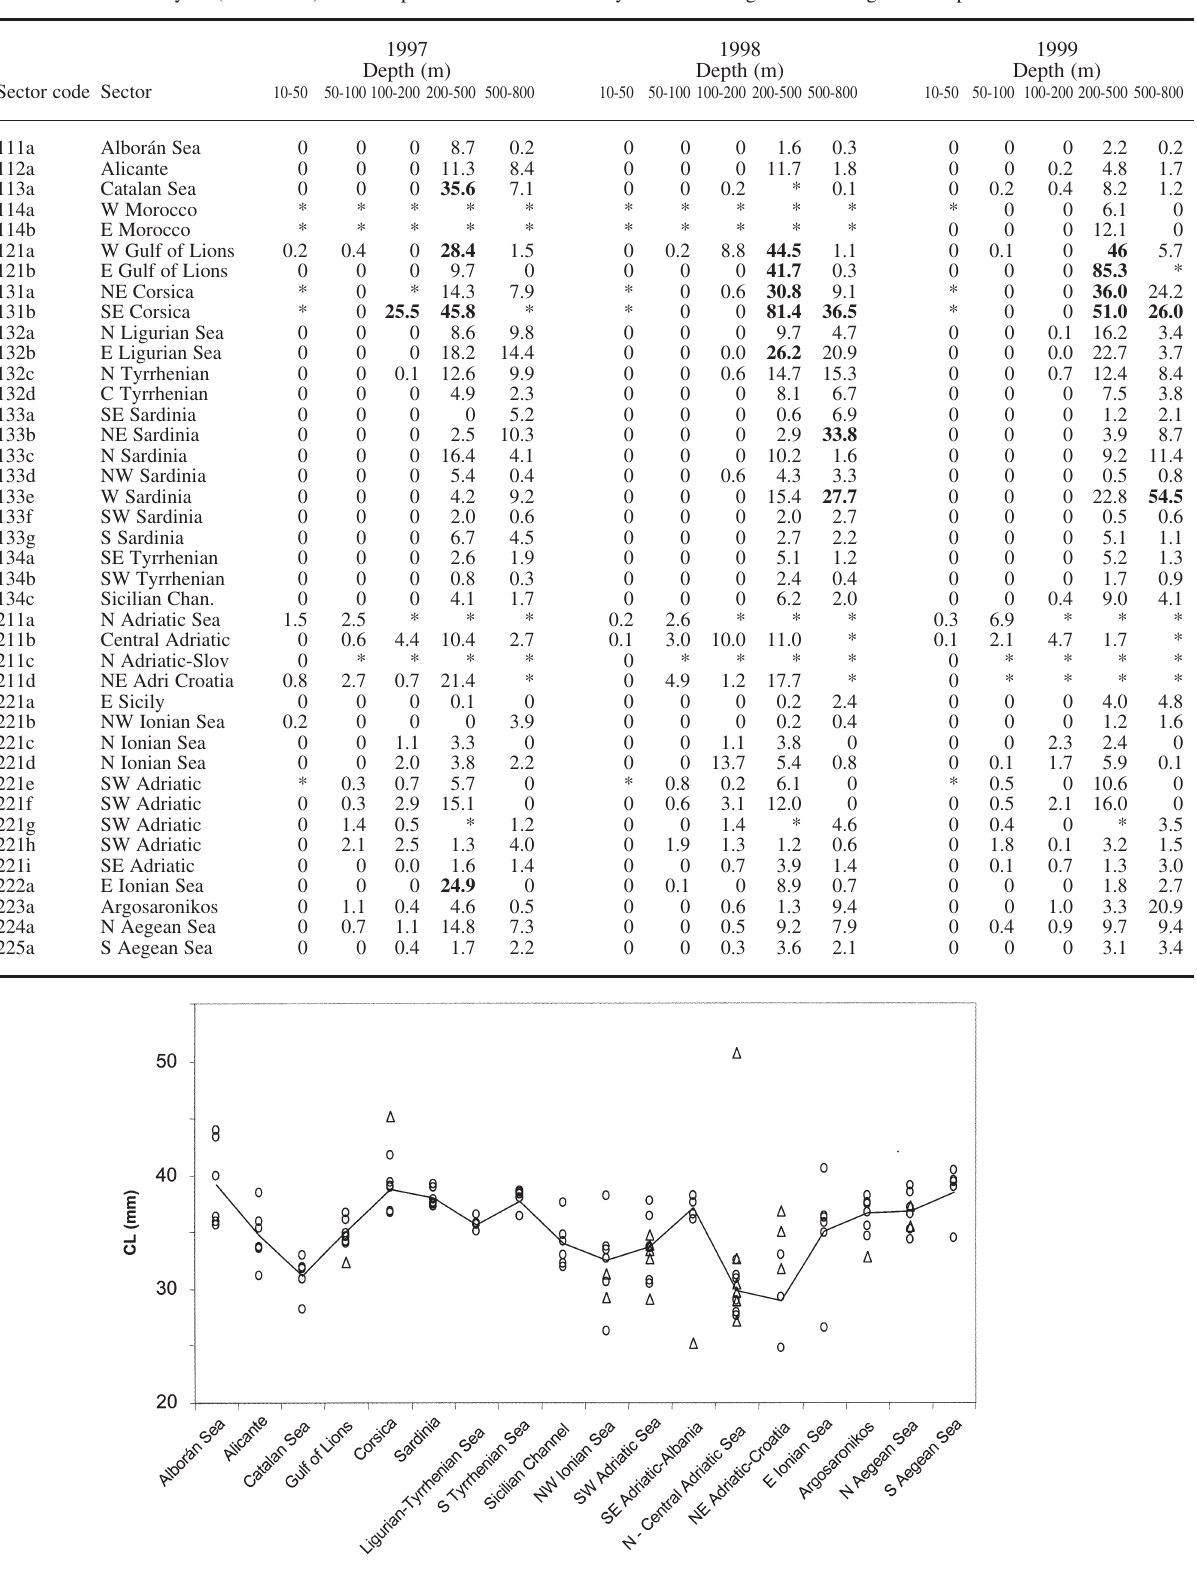
F IG . 1. – Mean sizes (CL, in mm) of Nephrops norvegicus obtained in 1994-1999 in the different geographical sectors.Triangle: shelf samples; open circle: slope samples. The black line follows the mean values of the slope